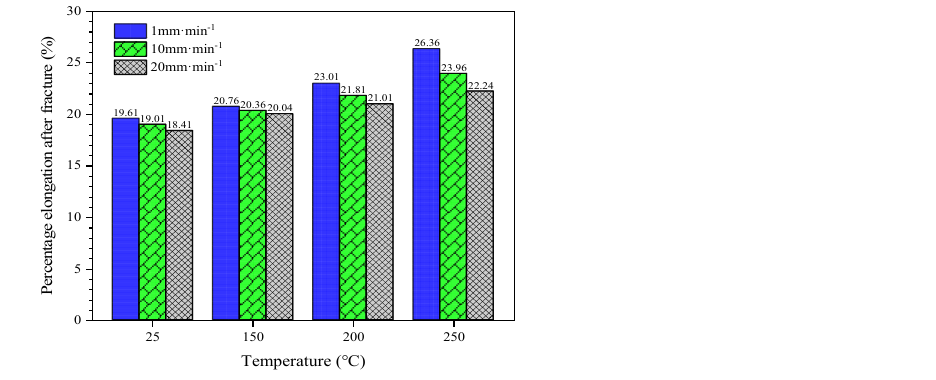
Figure 7. The percentage elongation after fracture of AZ31B at the different tensile temperatures and rates.